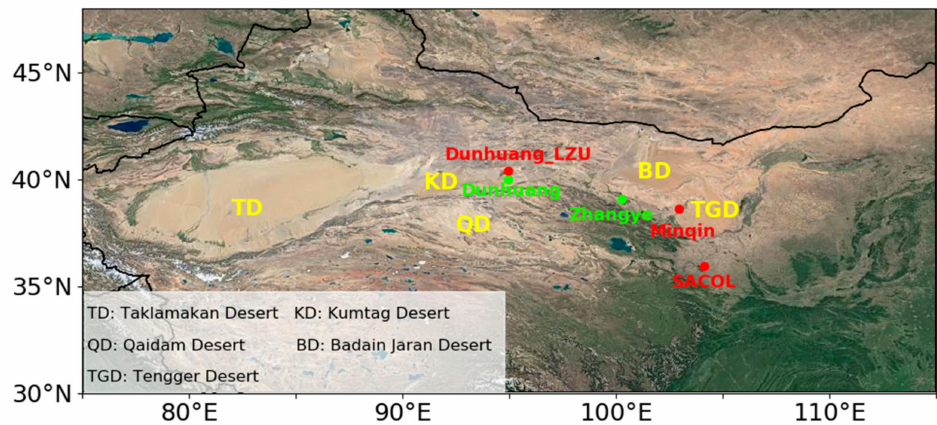
Figure 1. The geographical distribution of dust sources and the field observational sites in Northwest China. The sun- photometer (all sites) and lidar (only red sites) are utilized in this